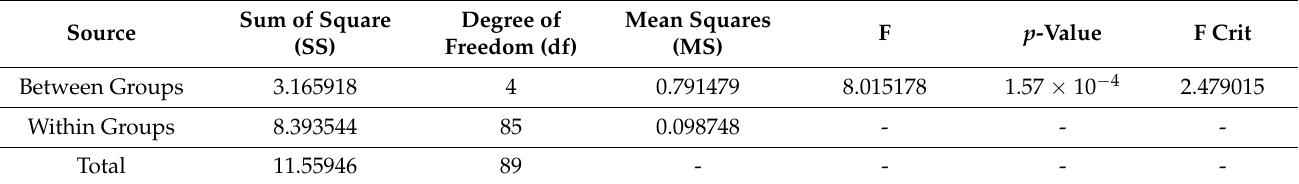
Table 3. Statistical parameters obtained from the ANOVA